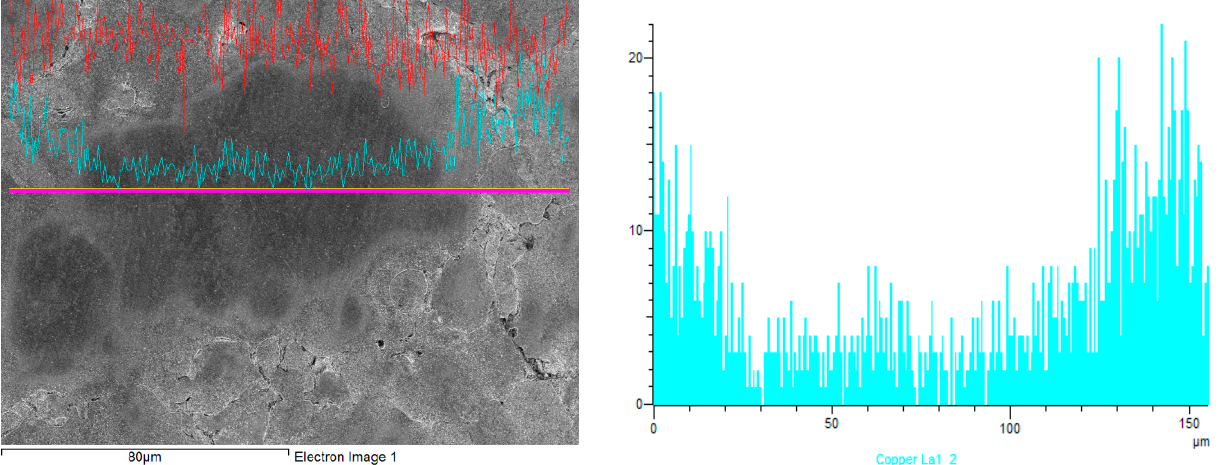
Figure 6. A region of sintered specimen originated in a single coated particle and contacts with its neighbors ( left ), and a copper concentration profile obtained from EDX line scan ( right ). The scan was taken from left to right side along the line marked in the left figure. The specimen with 3.2 wt.% Cu is presented, SEM.